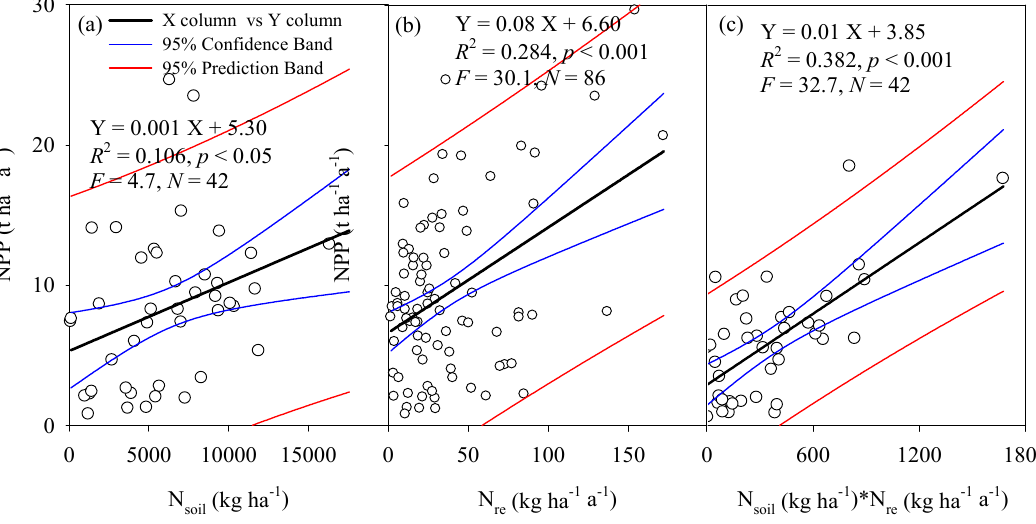
Figure 4. Relationships between net primary productivity (NPP) and soil N content (N soil ), annual litter N (N re ), and combinations of N soil and N re . N, number of observations; F , F Values.